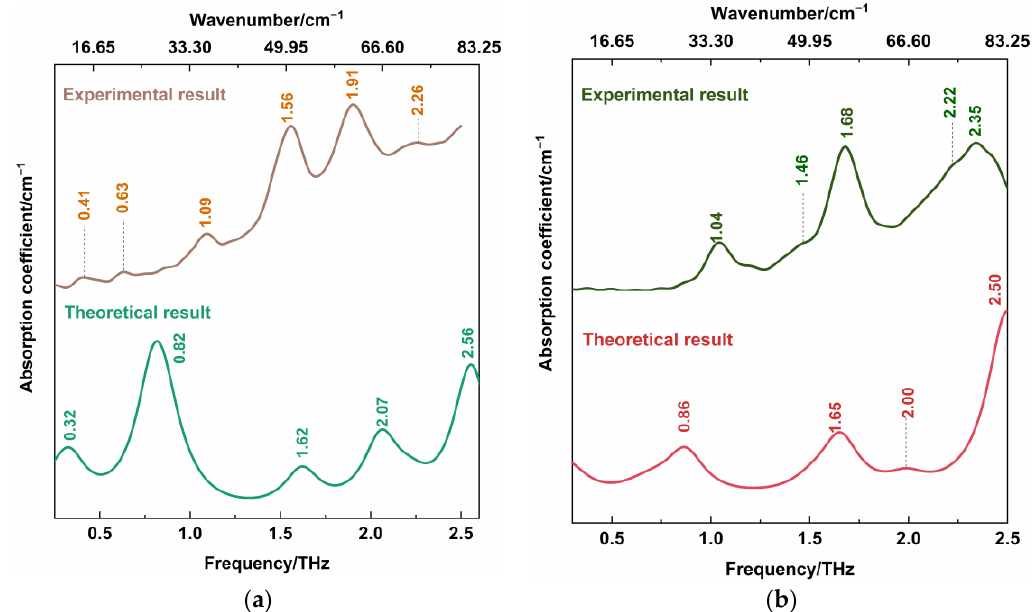
Figure 5. Comparison of THz spectra between theoretical and experimental results of the ( a ) CBZ-NIC co-crystal and ( b ) CBZ-SAC co-crystals. Table 1. Vibrational mode assignment of the CBZ-NIC co-crystal show in THz spectrum.